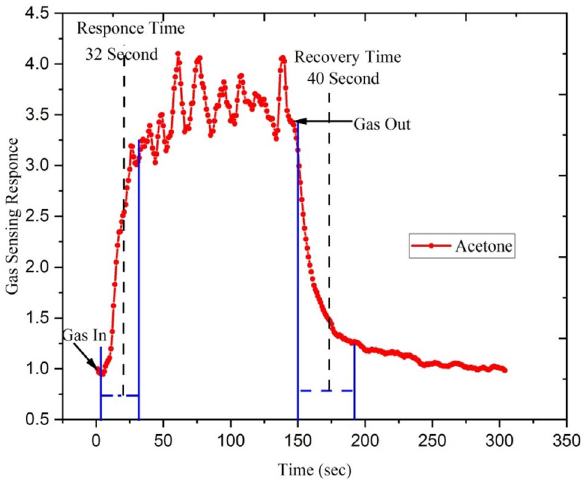
Figure 15. Response-recovery characteristics of the Ga doped ZnO (Ag 9+ ion irradiated at 5 × 10 13 ion fluence) thin film at the operating temperature 500 °C with 250 ppm concentration of acetone.